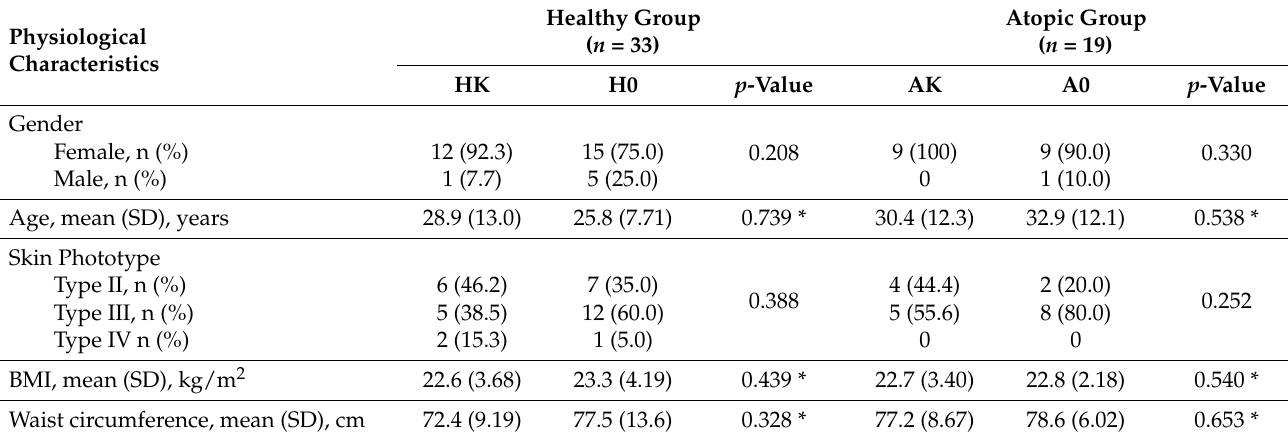
Table 2. Physiological characteristics of study participants (relative frequency (%); mean ±